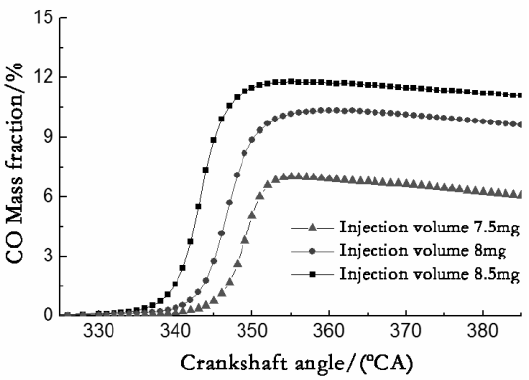
Figure 25. CO curves corresponding to different fuel injection volumes.